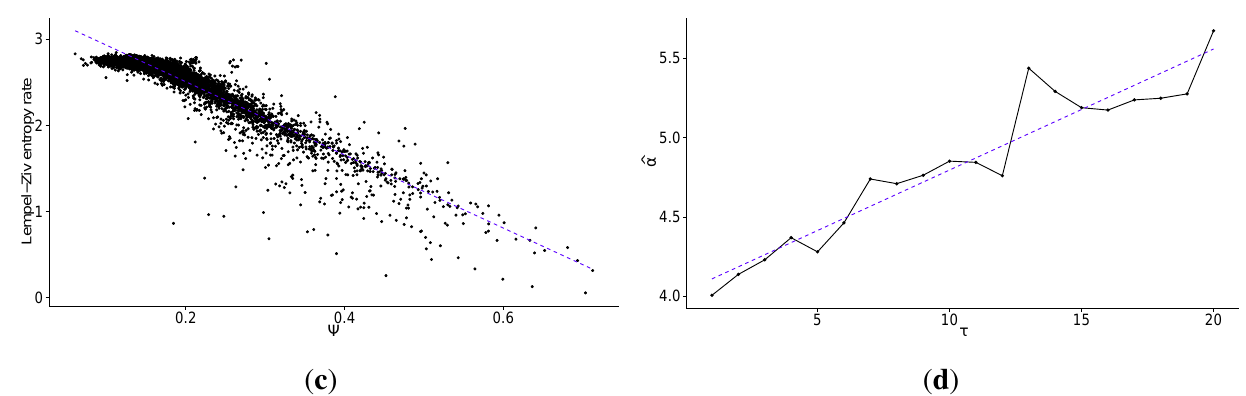
Figure 3. Multiscale analysis of transaction level logarithmic price change history for 707 stocks from Warsaw Stock Exchange sampled every (cid:28) price changes, discretized into eight quantiles: (a) the average Lempel–Ziv entropy rate among studied stocks as a function of scale (cid:28) (the dotted line denotes maximum for fully efficient/unpredictable market; error bars show (cid:6) one standard deviation); (b) the percentage of times the Maximum Entropy Production Principle correctly guesses the quantile of the next price change ( Ψ ) averaged over all studied stocks as a function of scale (cid:28) (the dotted line denotes the value which would be obtained with random guessing; error bars show (cid:6) one standard deviation); (c) the correlation between the Lempel–Ziv entropy rate and Ψ for all studied stocks and scales (with linear fit visible as the dotted line); (d) the scaling parameter of the power law fitted for Ψ as a function of scale (cid:28) (the dotted line shows a linear fit). We observe that